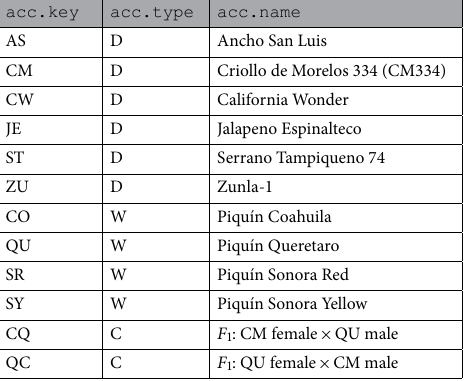
Table 1. Information in the data frame “ acc ” within the R package Salsa. Head of table in mono spaced font gives the names of the variables ( acc.key , acc.type and acc.name ), while cell content present possible values for those